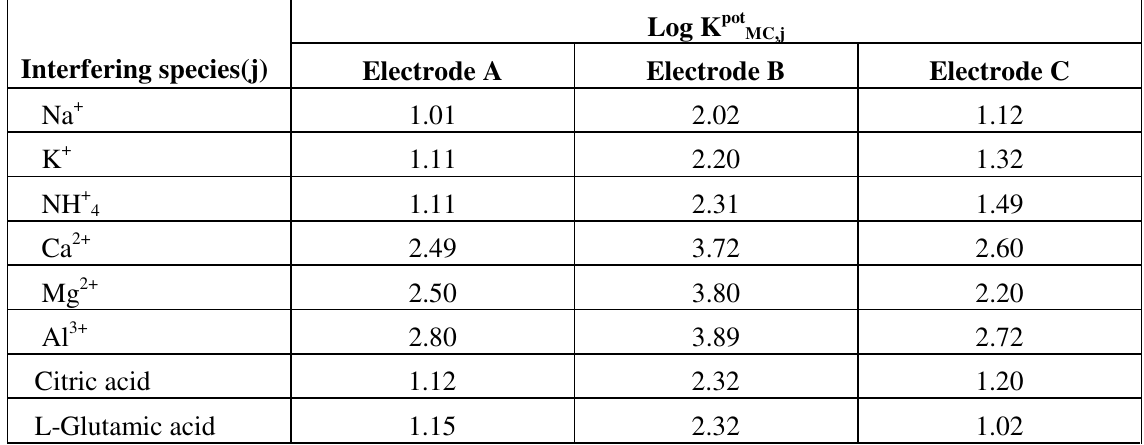
Table 2. Selectivity Coefficients of Electrodes.